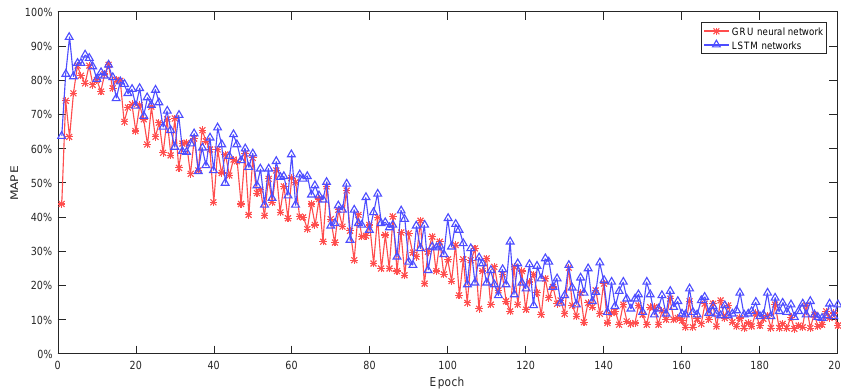
Figure 14. The MAPEs of network with LSTM and GRU layers in the same architecture with same samples during the training process.